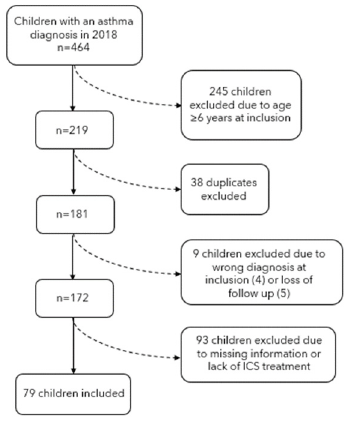
Figure 2. Flowchart of children included in the study.